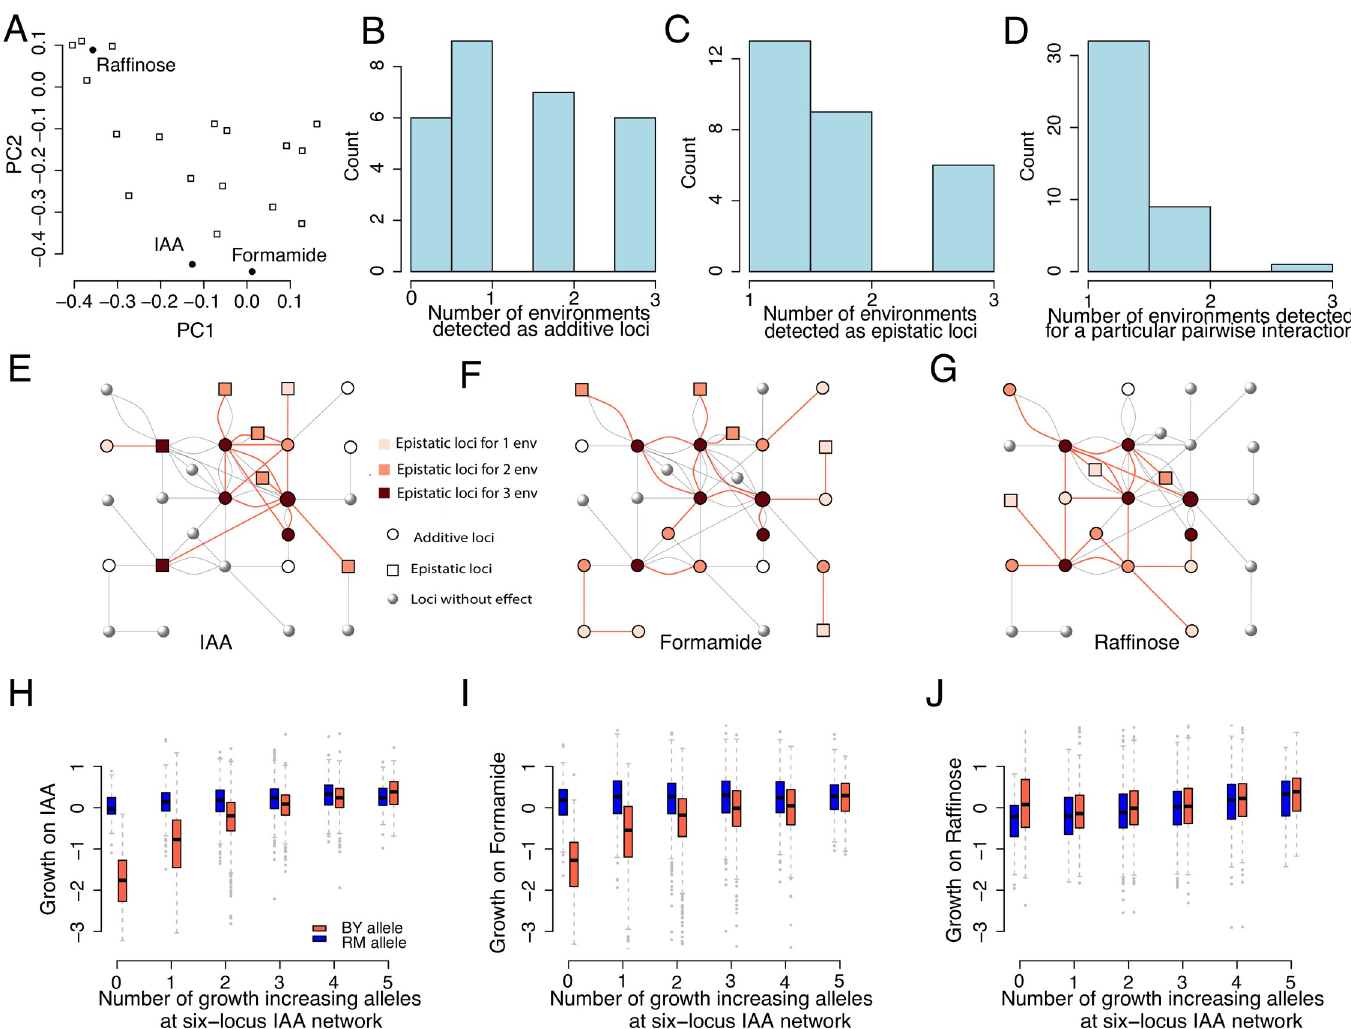
Fig 3. Illustrations of the relationships between environmental perturbations and contributions by high-order interactions contribute to yeast segregant growth. A) A two-dimensional PCA plot illustrating the resemblance in growths of yeast segregants across the 20 environments (media). Open squares represent a medium and the filled dots media with added IAA or Formamide or the medium where Raffinose was the carbon source. B/C) Histograms showing the number of environments in which the 28 loci had at least one significant epistatic interaction/additive effect. D) Histogram showing the number environments in which each of the 42 pairwise interactions were significant. E-G) Illustrations of differences and similarities in types of genetic effects (epistatic, additive or none) and activity of the interactions in the epistatic growth network on IAA, Formamide and Raffinose, containing media, respectively. The hub and radial loci in the IAA epistatic network studied earlier [31] are highlighted with red/black arrows. The red lines connects significant pairwise interactions reported in Bloom et al [30]. The grey lines indicate epistatic interaction detected in other media. Panes H-J) Each box plot represents a group of segregants with the same number of growth-decreasing alleles at the five radial QTLs, separated and colored based on the genotype at the hub QTL. The x axis gives the number of growth-decreasing alleles at the radial QTLs and the colour of the box indicates the genotype at the hub QTL (chrVIII: 98,622 bp; tomato/ blue corresponds to BY/ RM alleles).